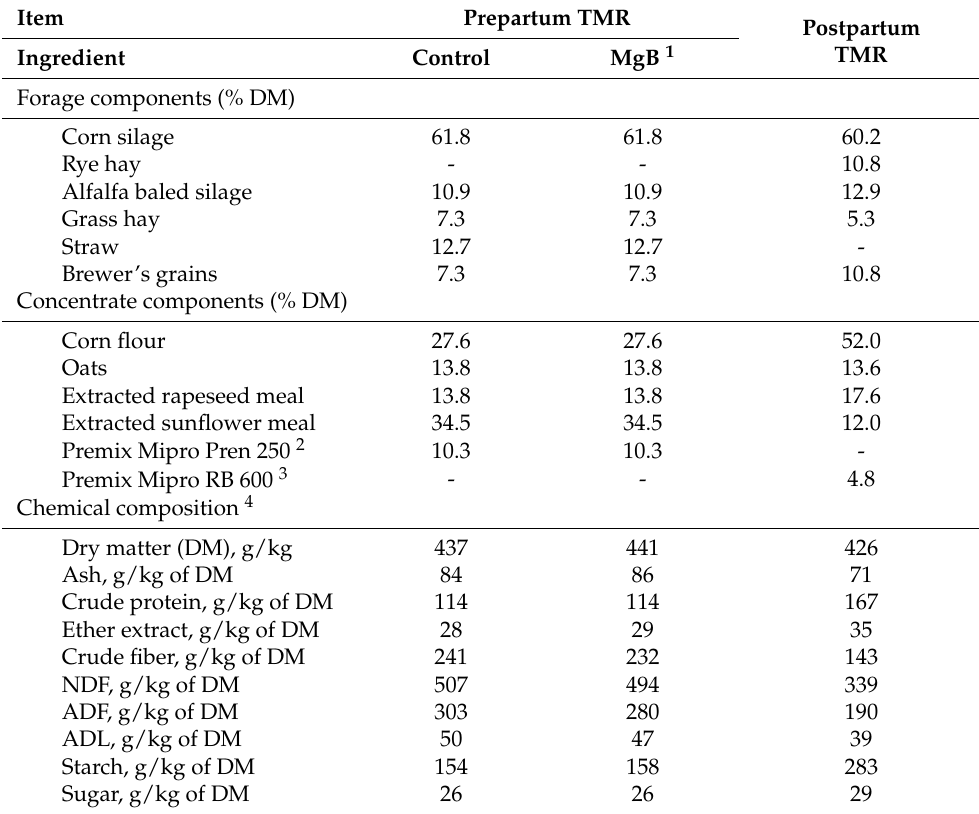
Table 2. Ingredient and chemical composition of prepartum and postpartum total mixed ration (TMR) diets of cows in the Control (n = 31) and magnesium butyrate (MgB) (n = 34) groups. Item Prepartum TMR Postpartum TMRIngredient Control MgB